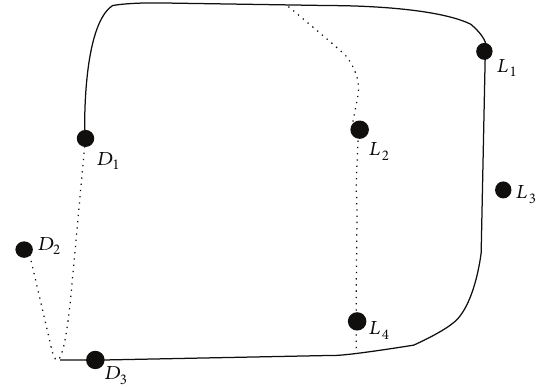
Figure 2: Illustration of the truck round